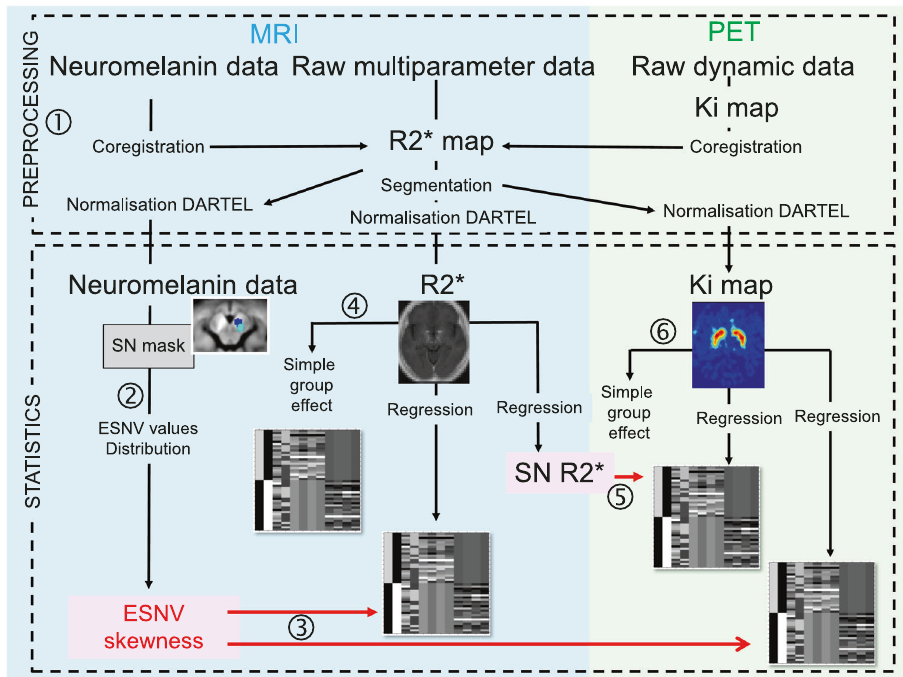
Fig. 6 Chart fl ow of data processing and analyses (see text). 1. Preprocessing ensures that MRI and PET data are fi nally registered in a common space. 2. Neuromelanin data consist of ESNV across all SN voxels, corrected for baseline values taken from bilateral cruces. 3. ESNV skewness act as regressor for R2* and Ki maps. 4. R2* maps serve in a group comparison. 5. R2* values in SN serve as regressor for Ki maps. 6. Ki map are used to show the voxelwise group effect. The gray diagrams illustrate design